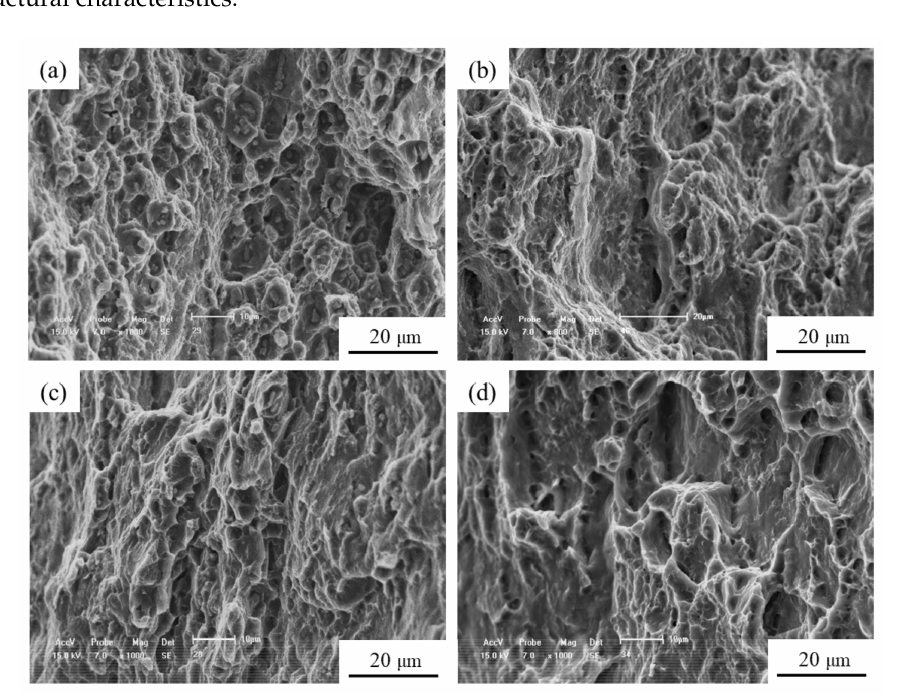
Figure 6. Fractures of the tensile specimens of ( a ) plate A, ( b ) plate B, ( c ) plate C and ( d ) plate